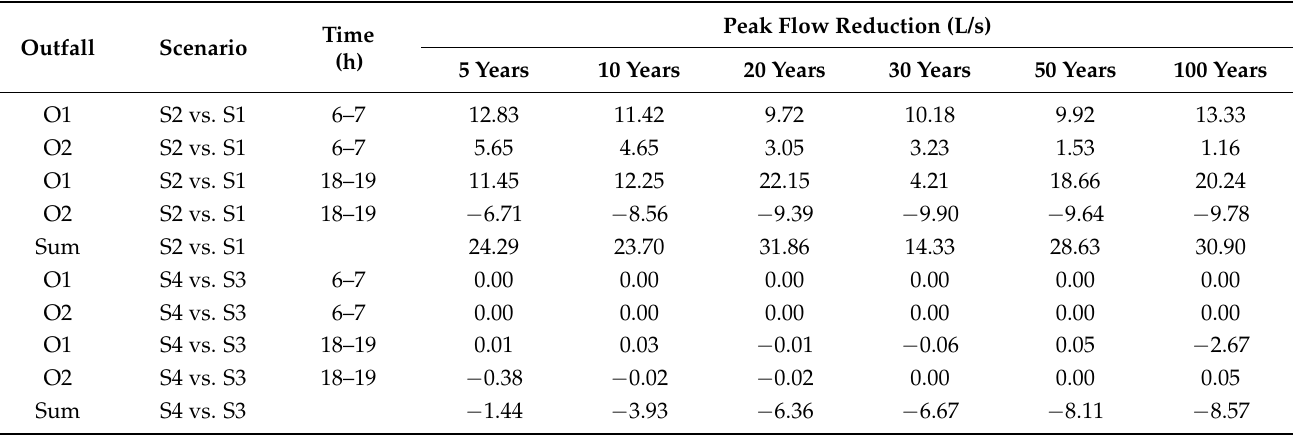
Table 7. Peak flow reduction of outfalls (O1 and O2) for the discharge route scenarios (S2 and S4) compared to traditional roof scenario (S1) and green roof scenario